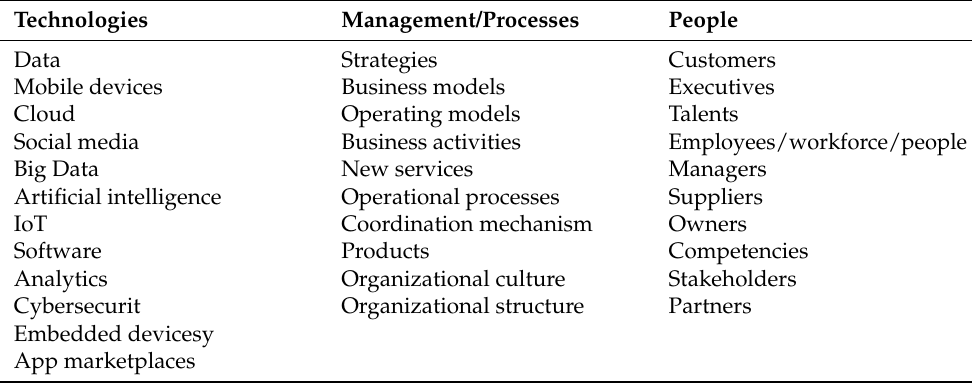
Table 2. Categories of the concept “digital transformation” and the elements within [1].